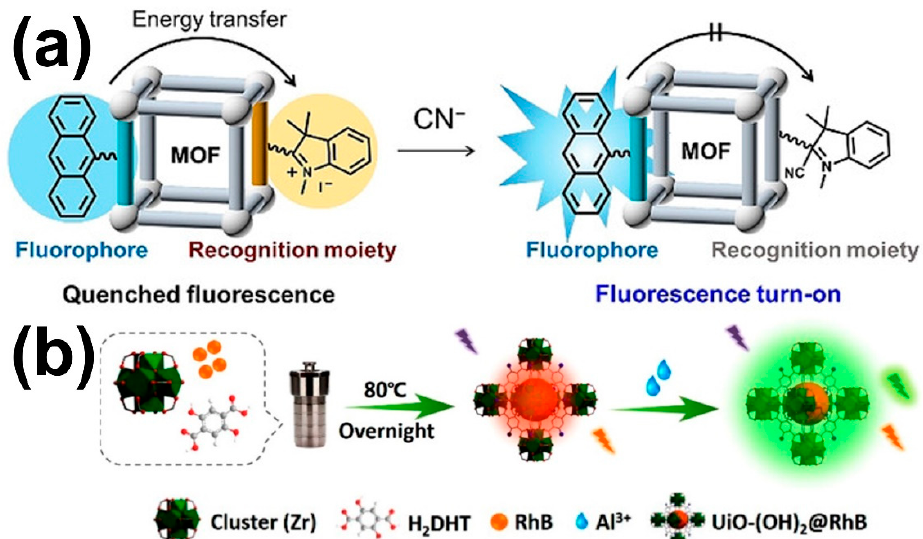
Figure 3. ( a ) Schematic representations for the design of a turn-on fluorescence sensor in multicom- ponent MOFs by integrating a fluorophore and a recognition moiety. Reprinted with permission from [67]. Copyright (2020) John Wiley and Sons. ( b ) Synthesis of UiO-(OH) 2 @RhB for the detection of Al 3+ ions. Reprinted with permission from [75]. Copyright (2020) American Chemical Society.